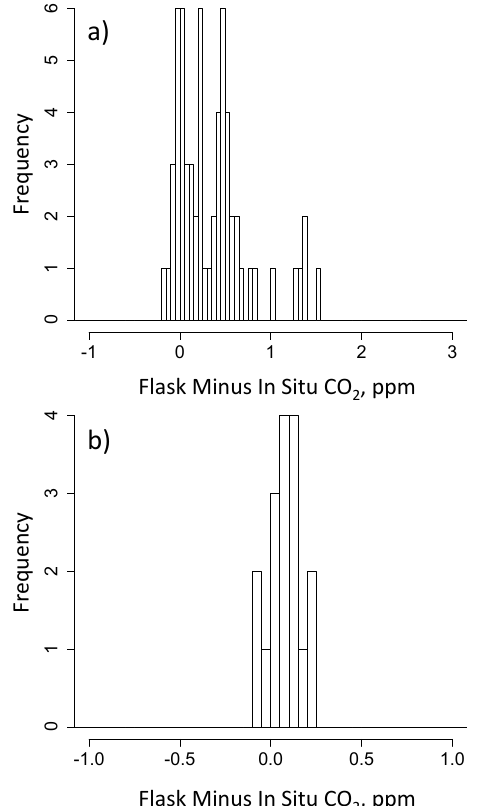
Fig. E3. Histograms of BAO PFP flask minus in situ differ- ences for conditions with atmospheric variability < 0.15ppm for (a) 1 January–19 July 2013 with PFP samples collected using the standard sampling protocol (mean = 0.36 ± 0.40SD, N = 62), and (b) for 20 July–30 September 2013, during which the PFP samples were collected using the modified conditioning protocol (mean = 0.08 ± 0.09 SD, N =